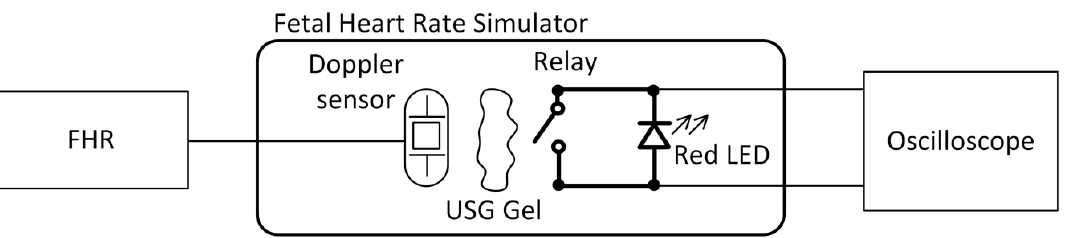
Figure 4. The scheme of the oscilloscope test.